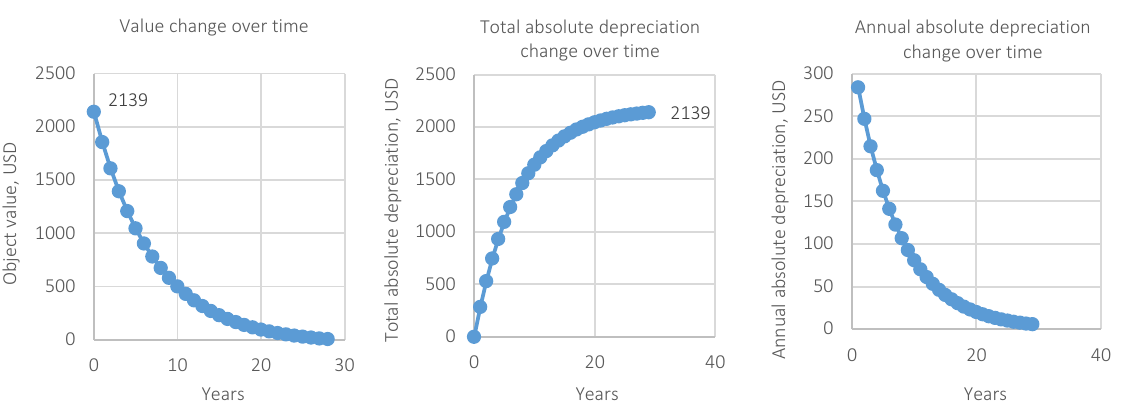
Figure 2. Graphs of the value change over time (left); total absolute accumulated depreciation (middle) and the annual (periodic) absolute depreciation (right). Traditional regressive depreciation model, based on